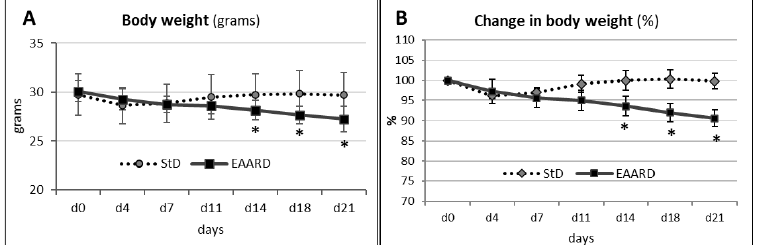
Figure 1. ( A ) Changes in body weight (grams, mean ± sd) during treatment. ( B ) Percentage change in body weight during treatment. EAARD-fed mice decreased body weight by approximately 10%. * p < 0.01.